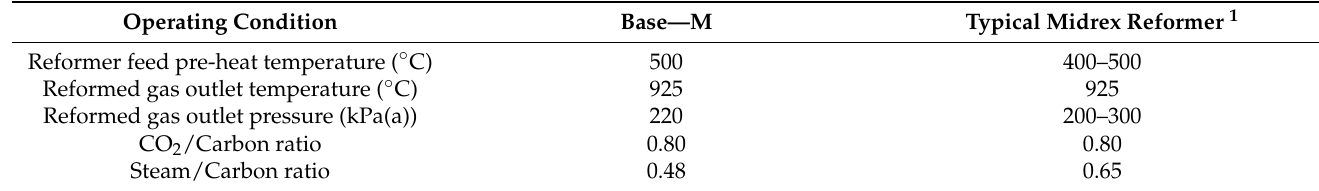
Table 5. Comparison of Base—M reformer operating conditions to expected ranges.